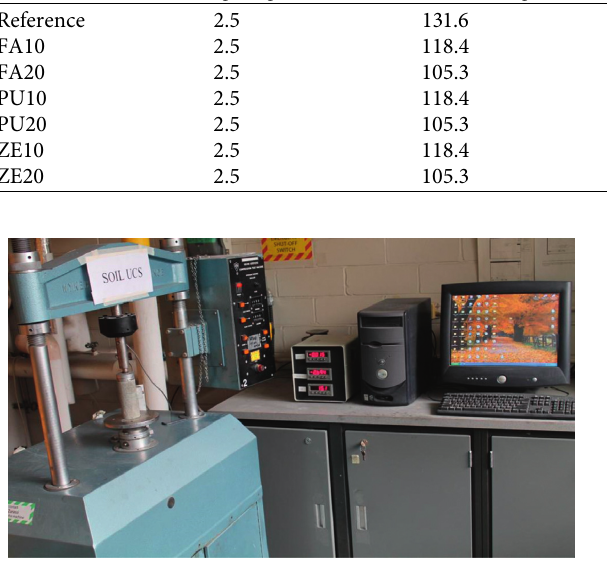
Figure 2: Experimental setup for unconfined compressive strength tests.